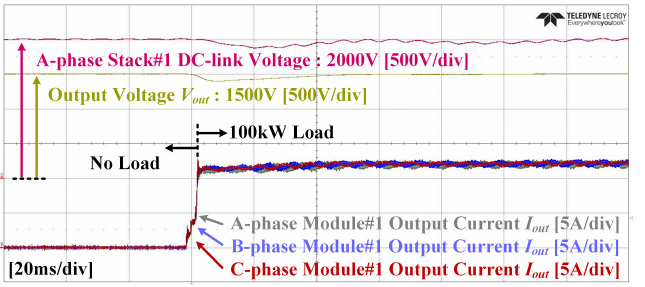
Figure 14. Experimental results of current sharing under 100 kW step load